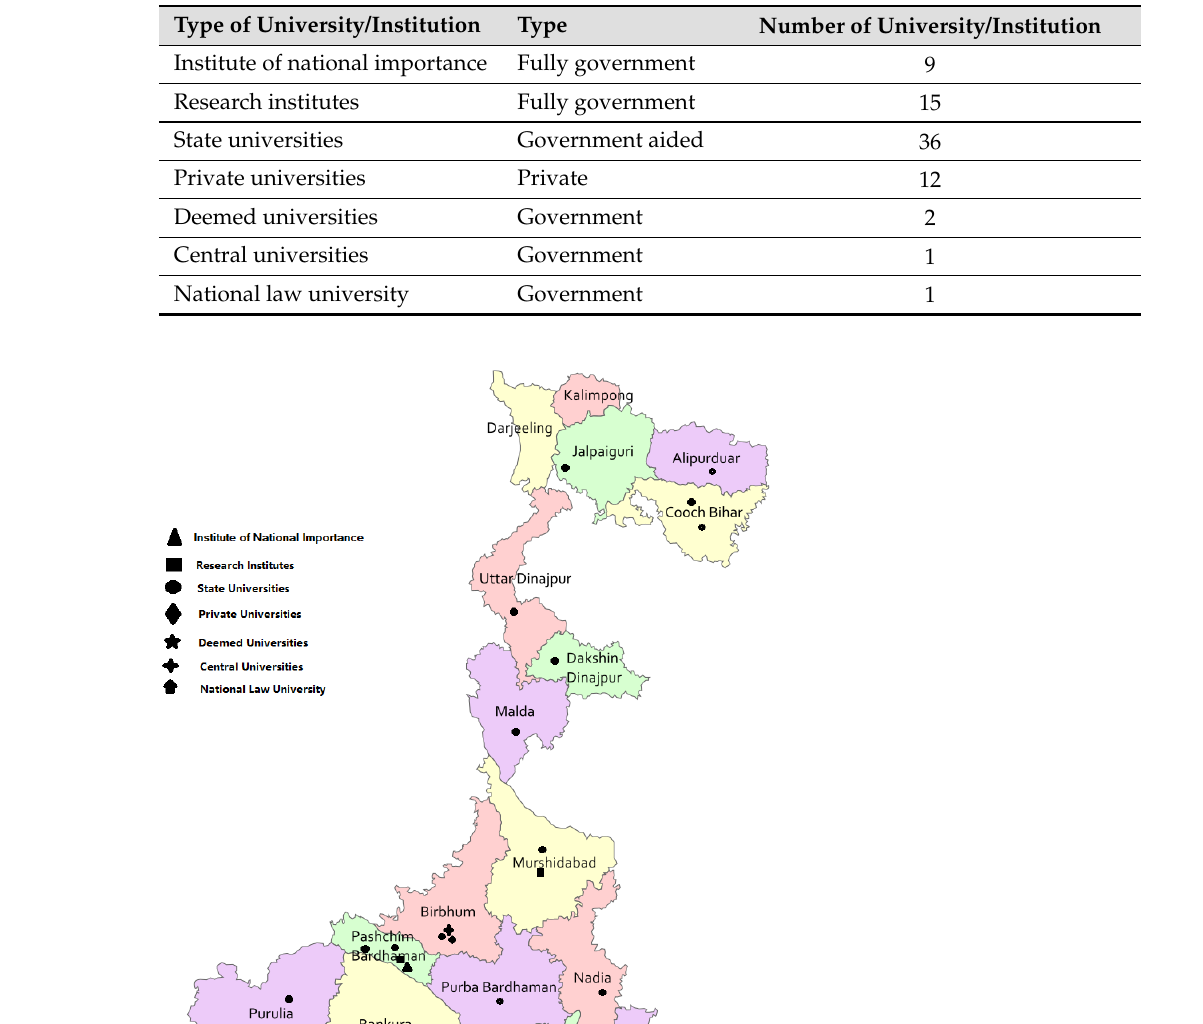
Table 4. Different type of university or institution in West Bengal, India [86,87].